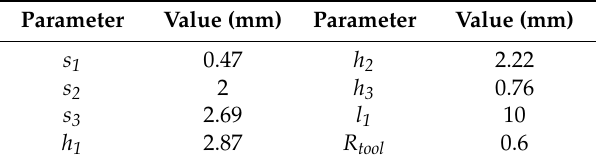
Table 2. E-plane bend design parameters